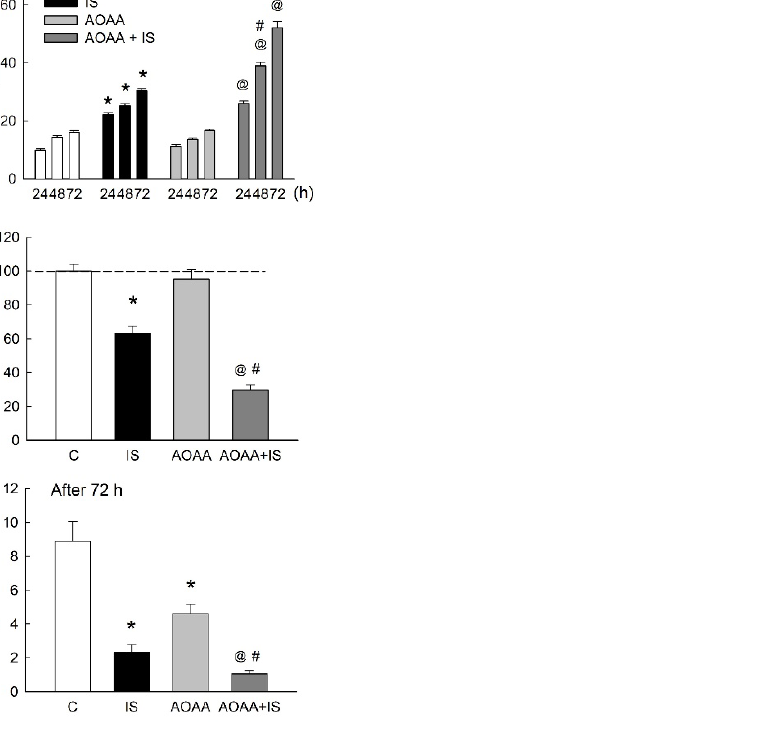
Figure 3. Inhibition of H 2 S-producing enzymes exacerbates IS-induced tubular damage. ( A ) Re- leased LDH was measured under treatment with 10 mM IS or 100 μM AOAA alone or in combina- tion for 24, 48, and 72 h. C, control group treated with vehicle solution. ( B ) The cell viability was examined using the MTT assay after 72 h of treatment. ( C ) H 2 S levels in the culture medium were measured after 72 h of treatment. Note that AOAA markedly attenuated cell survival and H 2 S for- mation. N = 6 in each group or time-point. * p < 0.05, IS vs. control ( C ) group; @ p < 0.05, AOAA+IS vs. AOAA group; # p < 0.05, AOAA+IS vs. IS group.